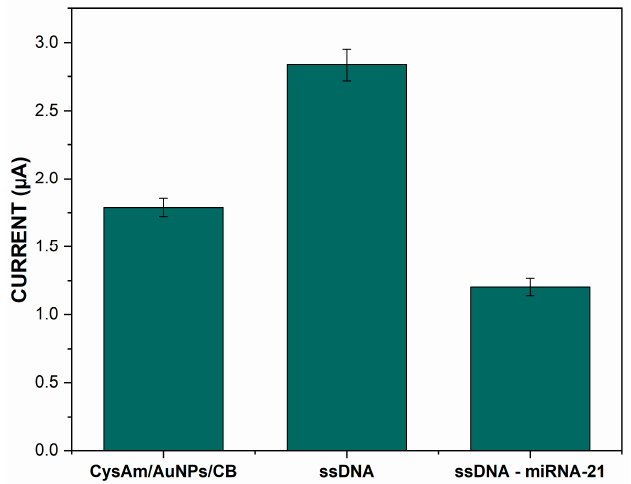
Figure 4. Differential pulse voltammetry reduction current of MB on CysAm/AuNPs/CB/PGE (RSD% = 3.73%), BSA/ssDNA/CysAm/AuNPs/CB/PGE (RSD% = 4.18%), and miRNA-21/BSA/ssDNA/CysAm/AuNPs/CB/PGE (RSD% = 5.24%) after incubation in 20 µM of MB at Tris-HCl buffer (20 mM, pH 7.00) including 20 mM NaCl for 5 min and being washed with the same buffer including 20 mM NaCl (n = 3).